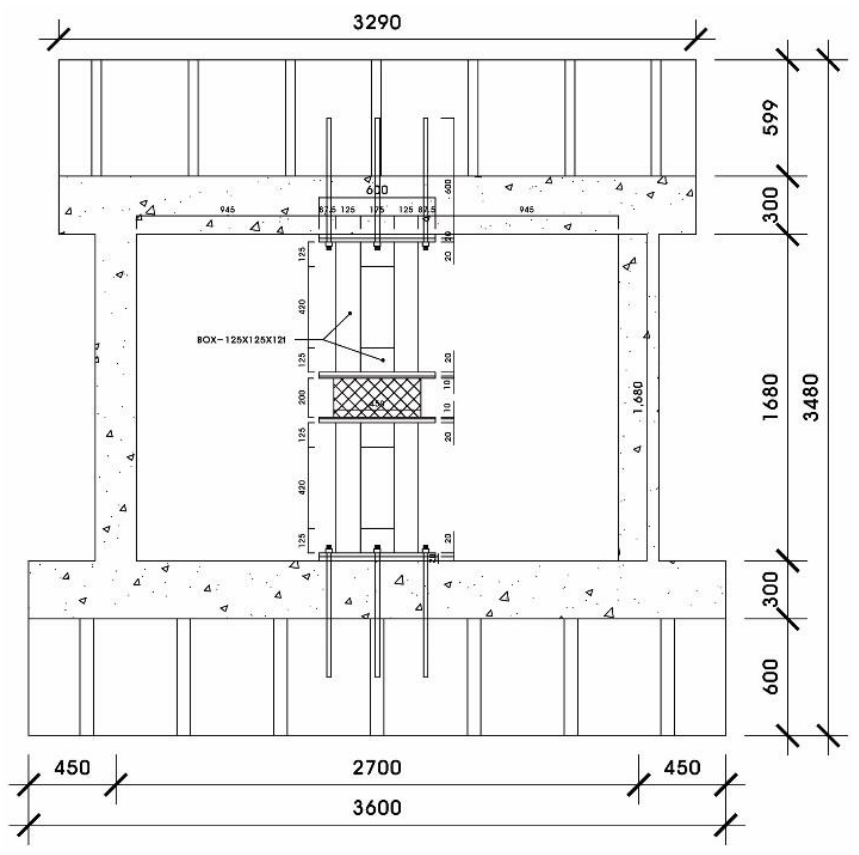
Figure 7. Installation of the Kagome damper.